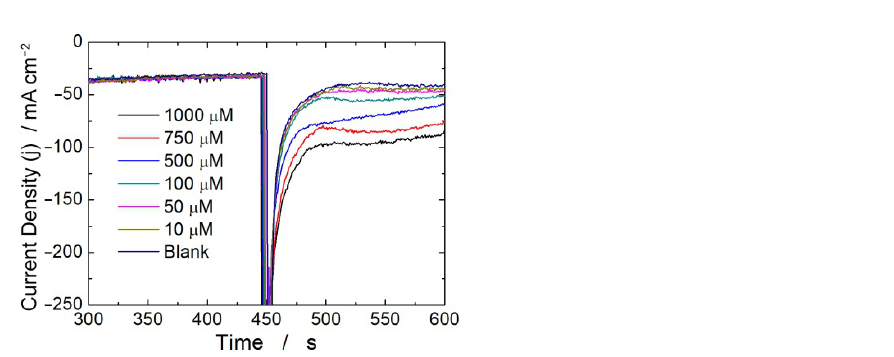
Figure 1. Effect of increasing H 2 O 2 concentration on CH experiment carried out at − 800 mV vs. SCE using diluted MEM medium.